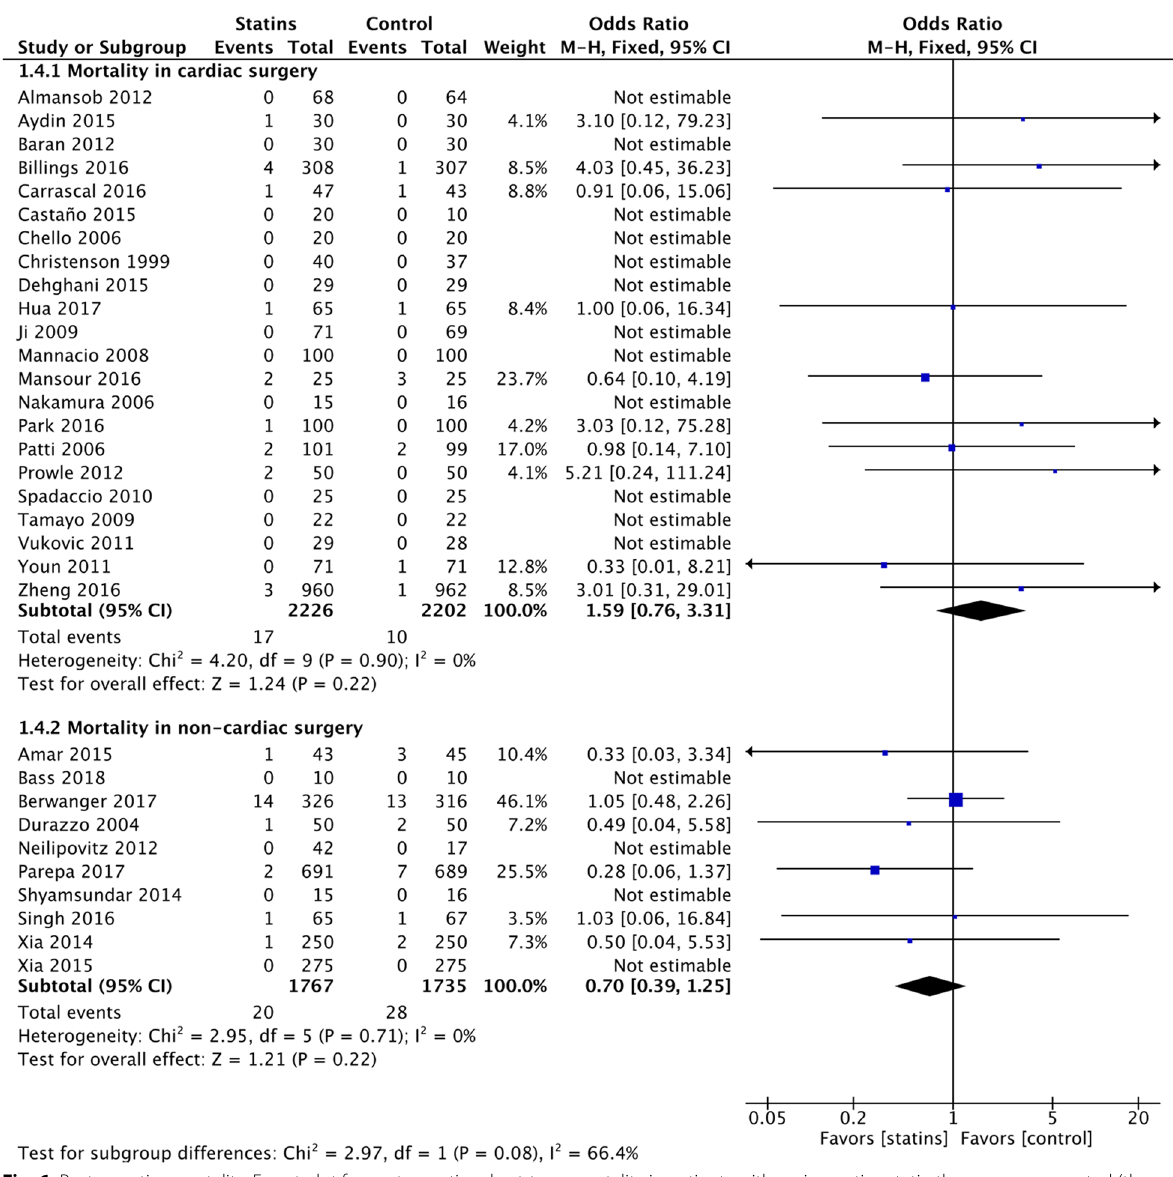
Fig. 6 Postoperative mortality. Forest plot for postoperative short-term mortality in patients with perioperative statin therapy versus control (the longest follow-up available, median 30